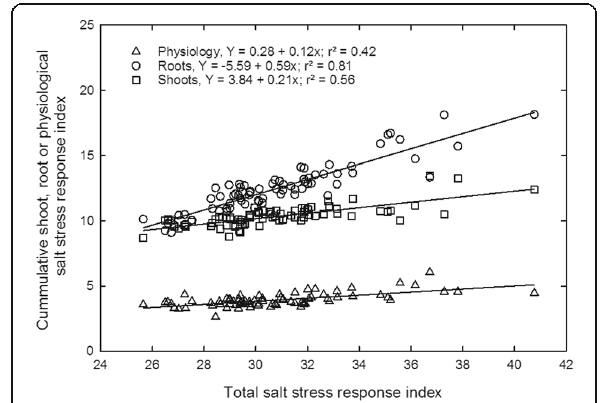
Fig. 5 Relationship of total salt stress response index with the total shoot, root, and physiological salt stress response index for all the rice genotypes. Measurements were taken 37 days after sowing